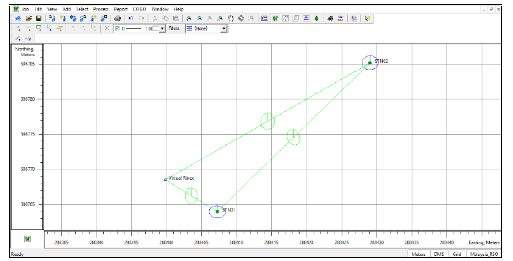
Figure 11. The example of post processed for using Topcon Tools software version 8.2.3